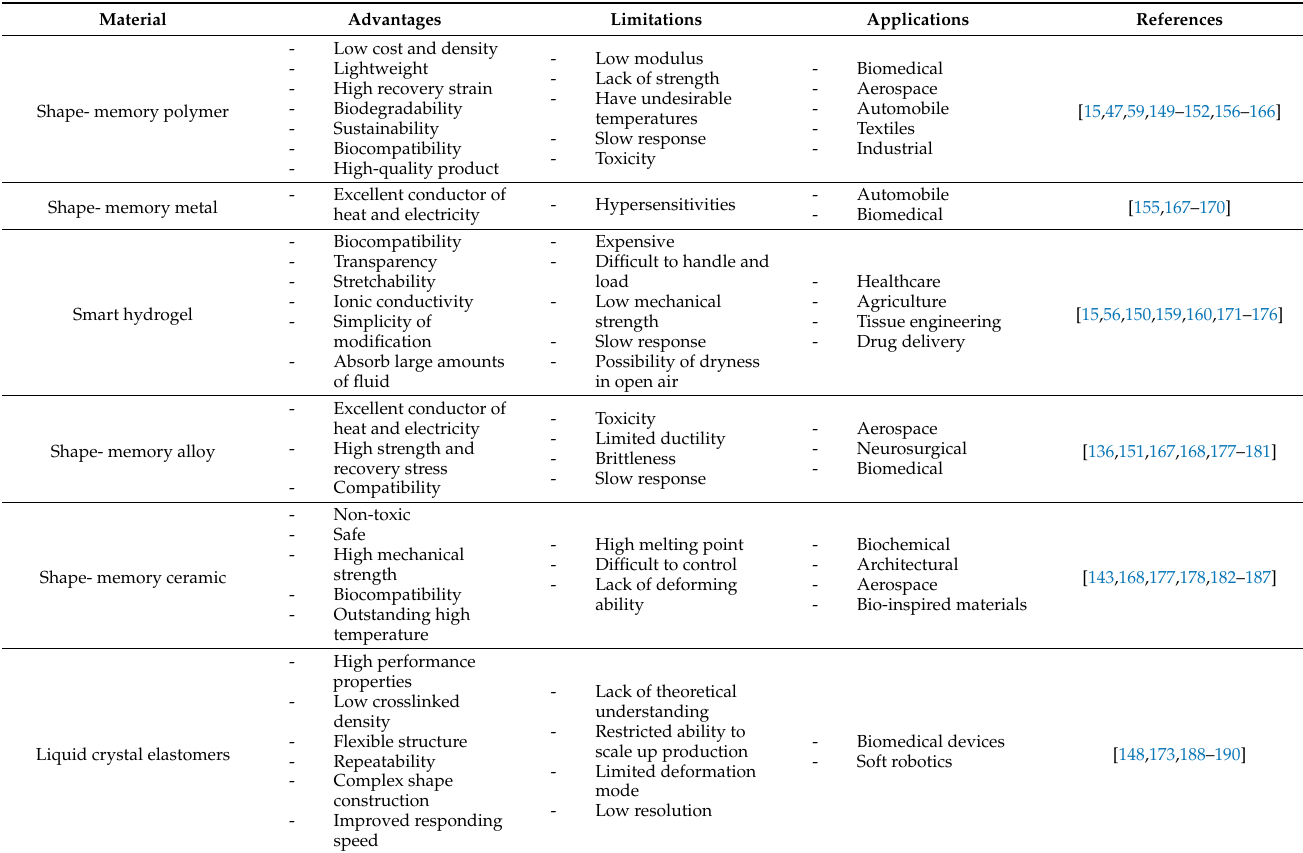
Table 4. Summary of 4D Printing Technology